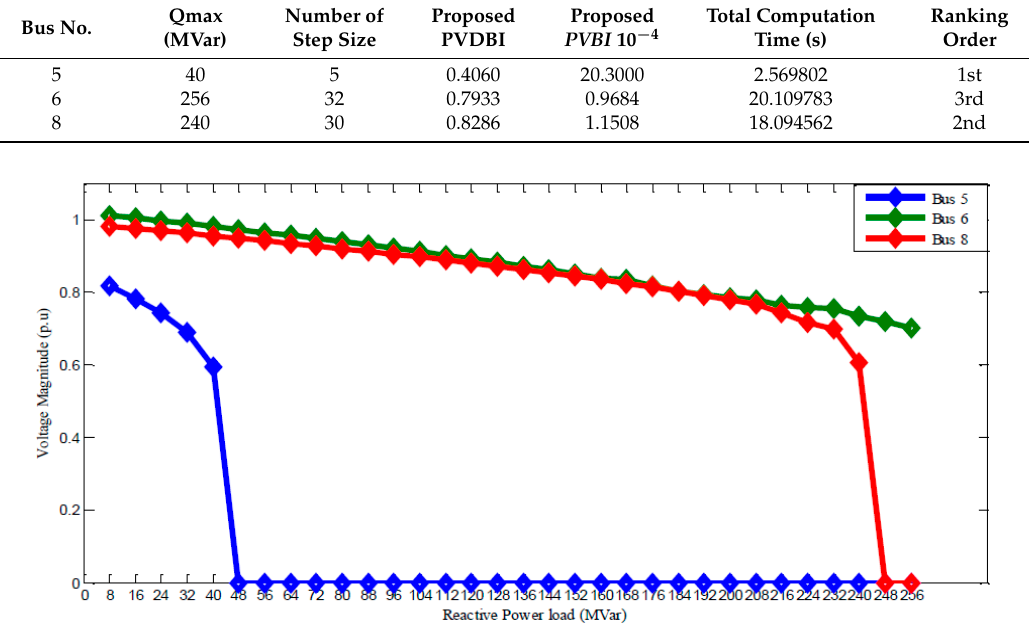
Table 2. Results of the proposed performance voltage bus index ( PVBI ) for the 9-bus test system. PVDBI: performance voltage deviation index.